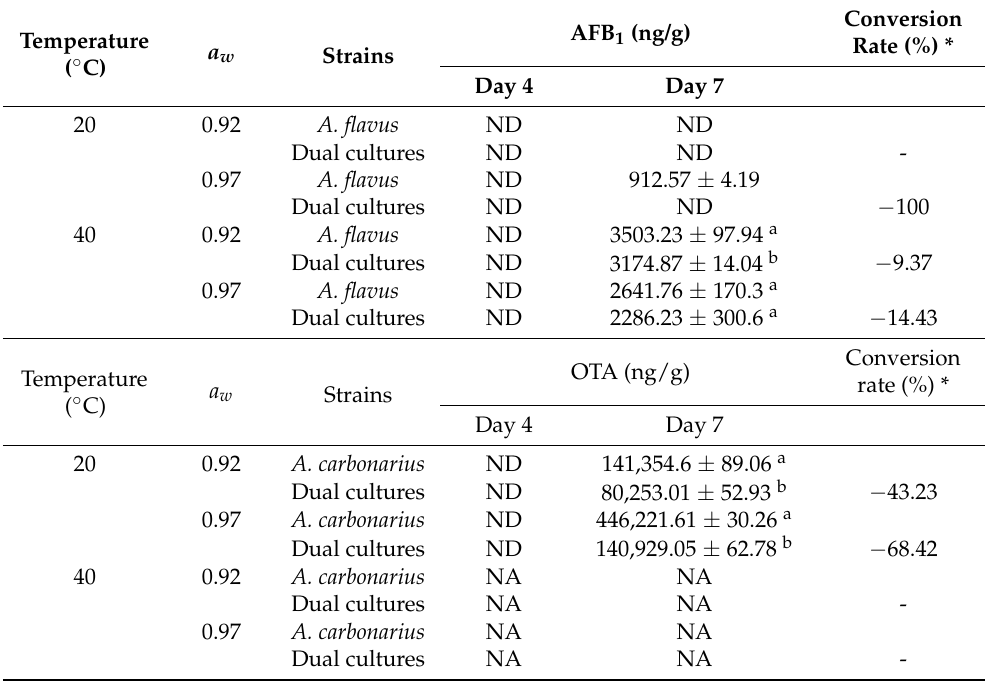
Table 3. AFB 1 and OTA production by A. flavus and A. carbonarius in single and dual cultures with A. oryzae on chili-based agar with 0.92 a w and 0.97 a w for 4 and 7 days at 20 ◦ C and 40 ◦ C. Conversion AFB 1 (ng/g) Temperature Rate (%) * a w Strains ( ◦ C) Day 4 Day 7 20 0.92 A. flavus ND ND Dual cultures ND ND - 0.97 ND 912.57 ±